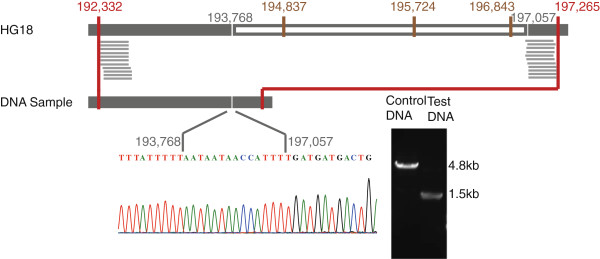
A 3290-bp deletion that skips three consecutive restriction sites on chromosome 17. Ditags were used to design a pair of primers to amplify the breakpoint-containing sequences. The results showed bands of different sizes for the control and the test DNA. The breakpoint sequence was identified by direct Sanger sequencing with a micro-insertion observed at the break sites.